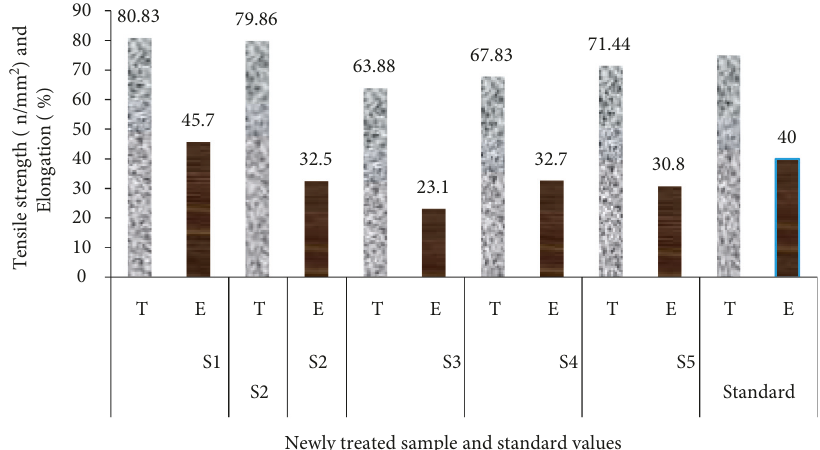
Figure 4: Tensile strength (T) and elongation (E) of pickled skin.